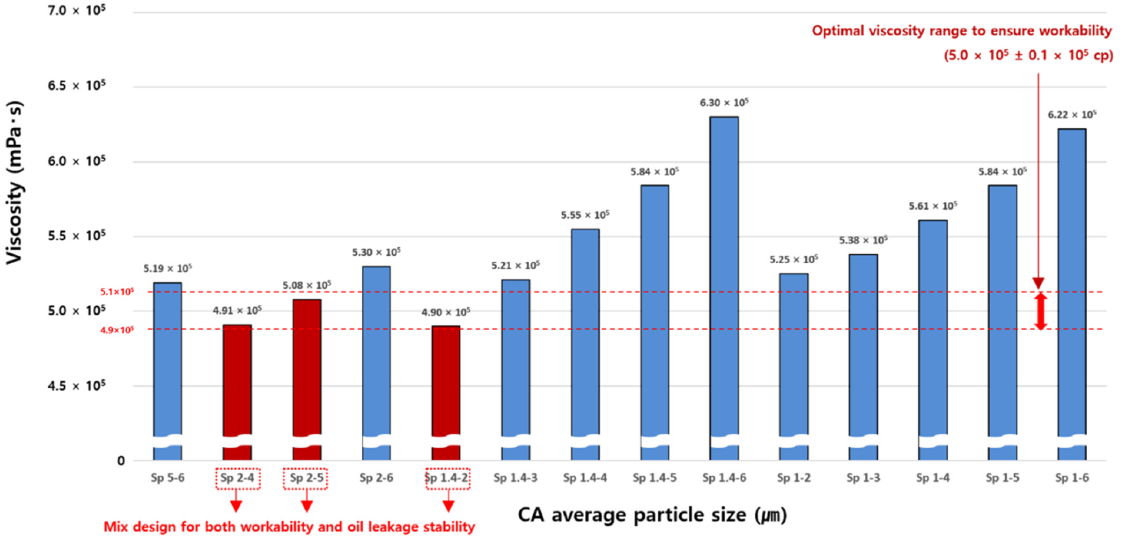
Figure 12. Results of workability analysis on samples with oil leakage stability.